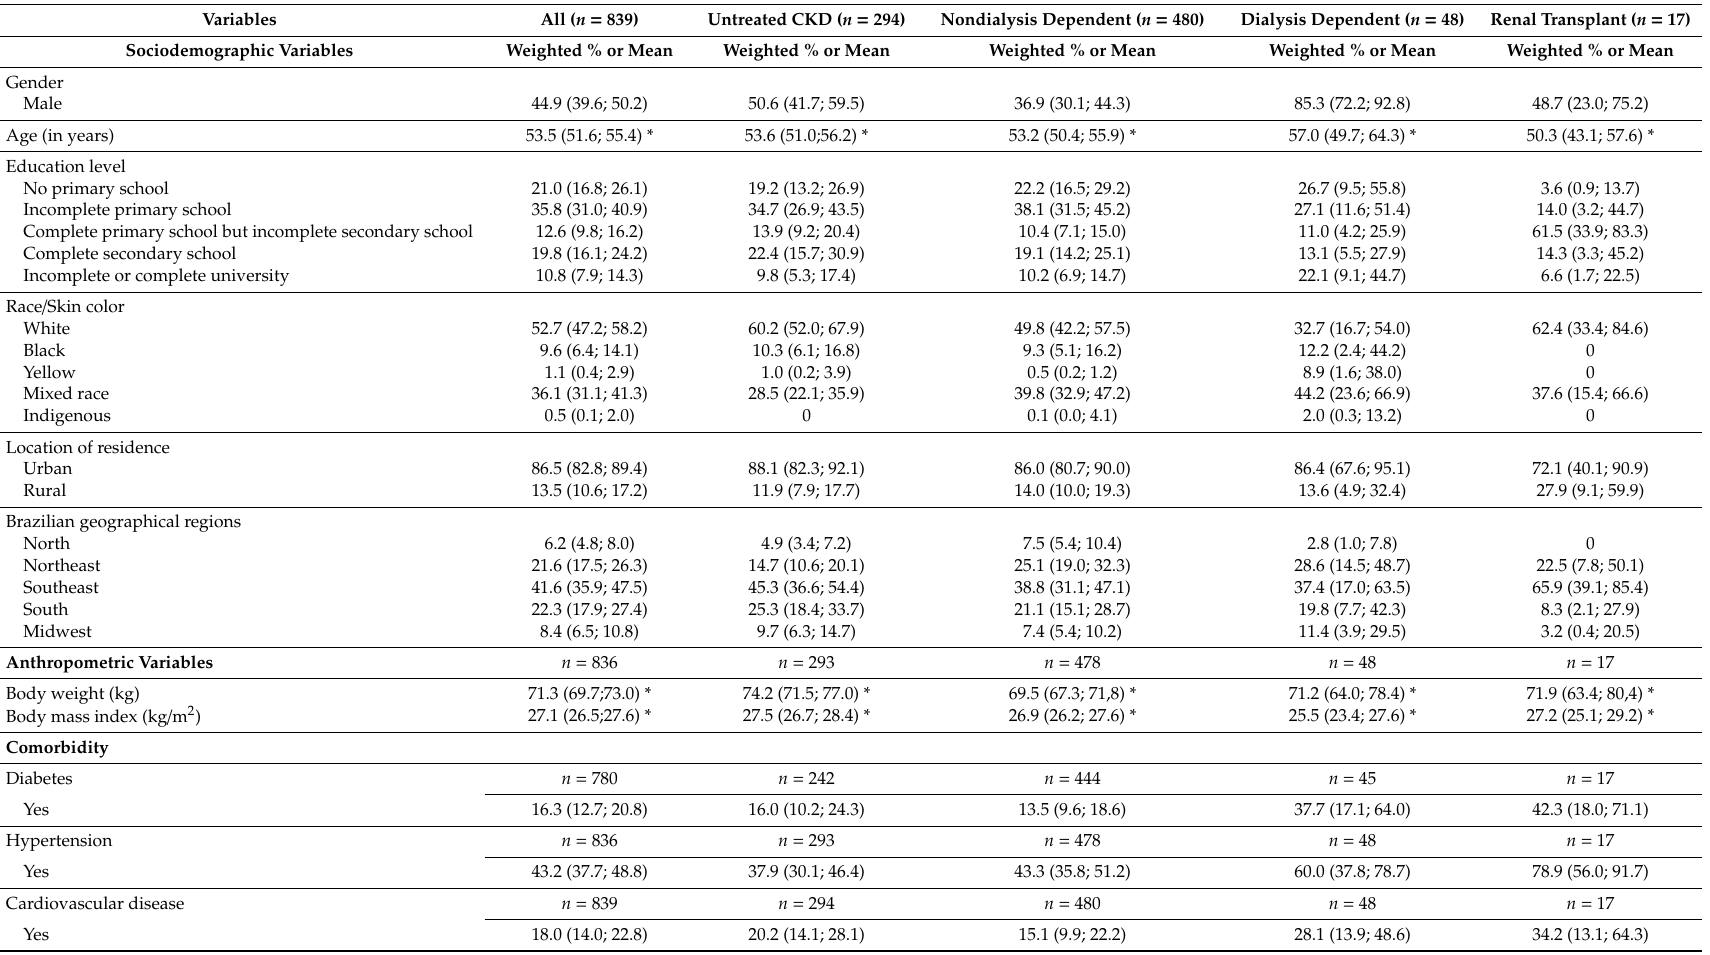
Table 2. Main characteristics of participants with CKD from the Brazilian NHS, 2013 ( n =